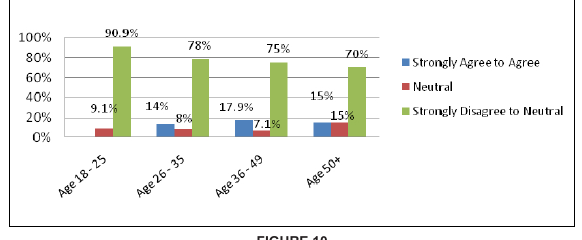
FIGURE 10 Safe to supply private information via email for banking purposes – per age